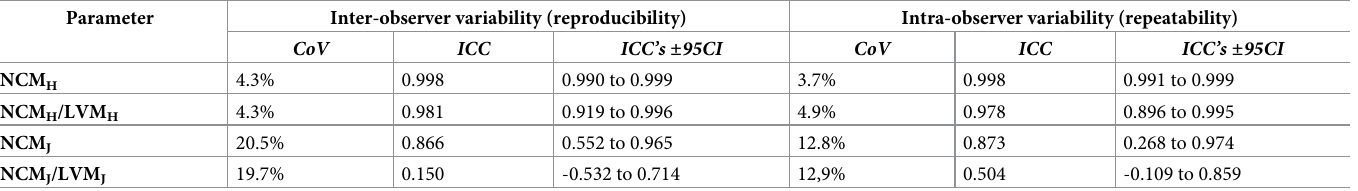
Table 8. Comparison of the inter- and intra-observer variability between the method based on Hautvast’s computed algorithm and Jacquier’s approach of noncom- pacted myocardial mass evaluation. Parameter Inter-observer variability (reproducibility) Intra-observer variability